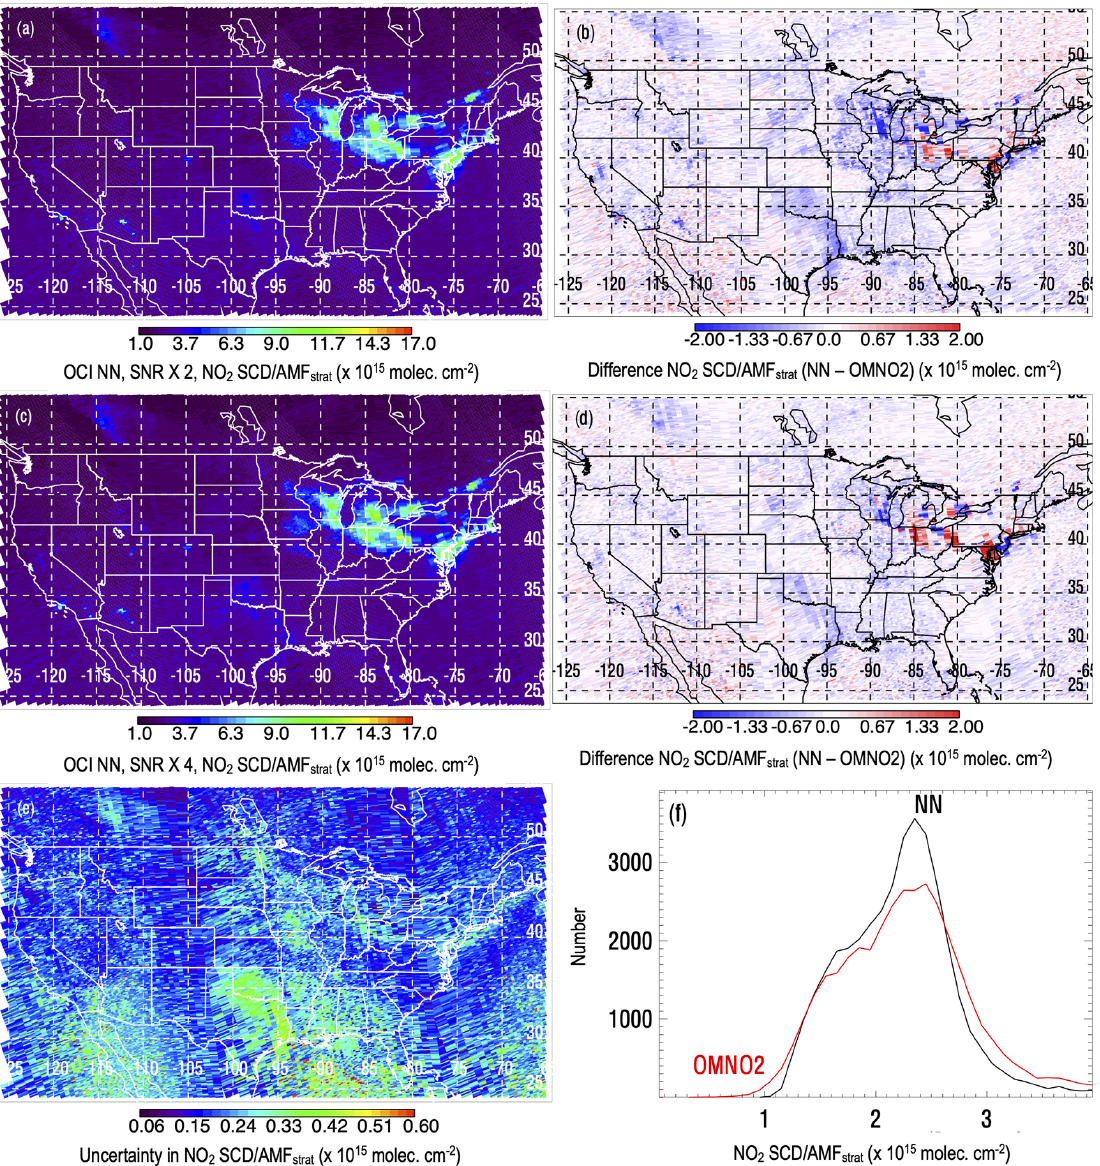
Figure 6. Similar to Fig. 5 showing data from 28 January 2005 (day not used in fitting): (a, c) NO 2 SCDs normalized by the stratospheric air mass factor (normalized SCD) and for NN algorithms trained on data sets using OCI spectral characteristics and a fitting window of 355– 500nm, evaluated at each OMI pixel using 2 × and 4 × the SNR from the model of Fig. 1b, respectively; (b, d) corresponding differences with respect to OMNO2 normalized SCDs shown in Fig. 5a; (e) fitting uncertainties in normalized SCD from OMNO2; (f) histograms of the lower end of normalized SCDs from OMNO2 and the NN model with 2 × the OCI